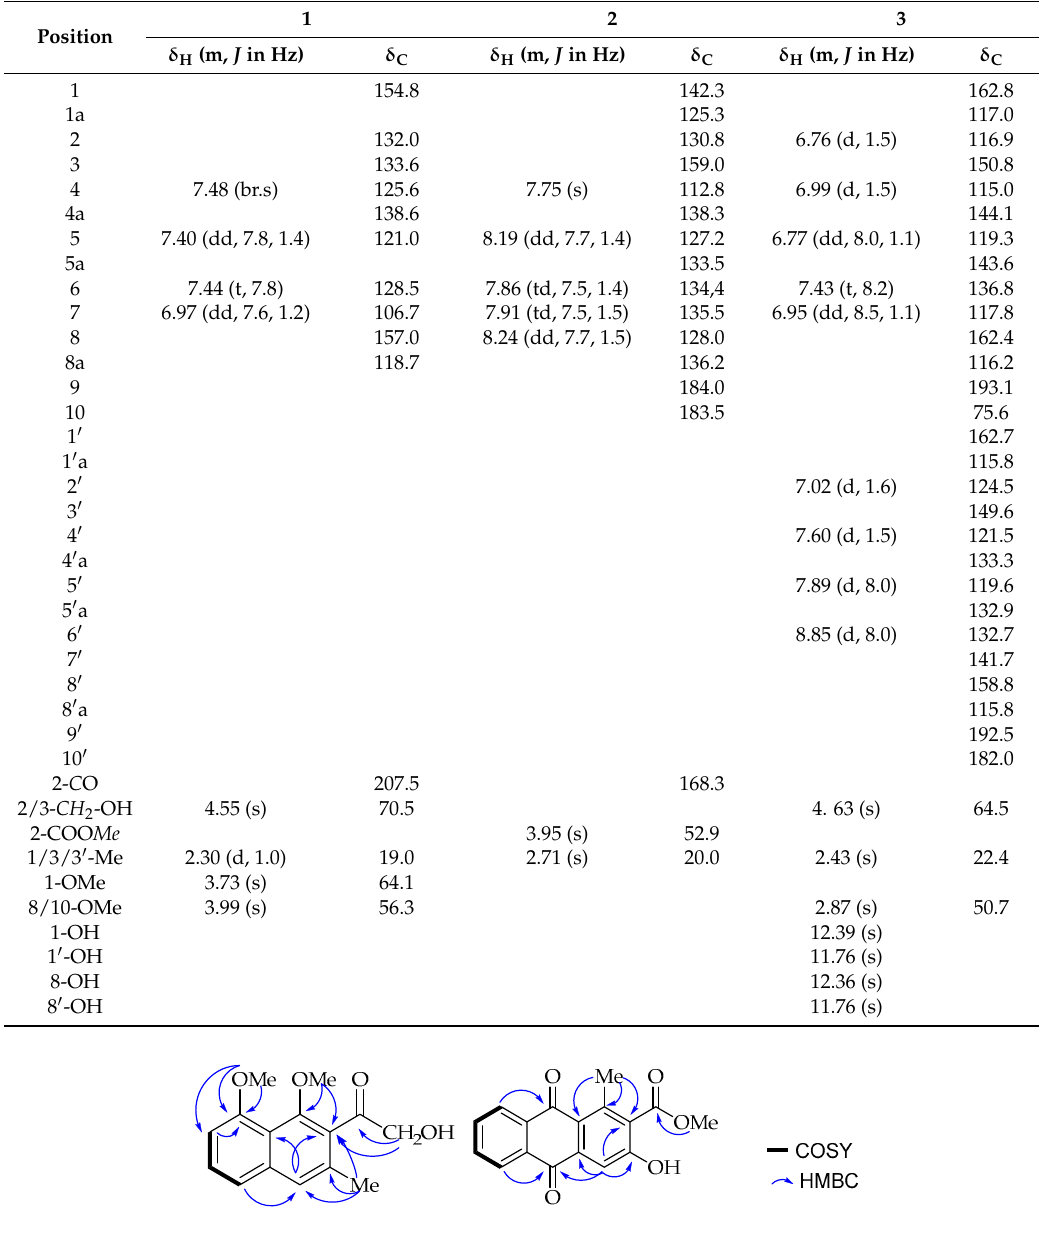
Table 1. 1 H (500 MHz) and 13 C (125 MHz) NMR data of compound 1 , 2 (acetone- d 6 ) and 3 (CDCl 3 )